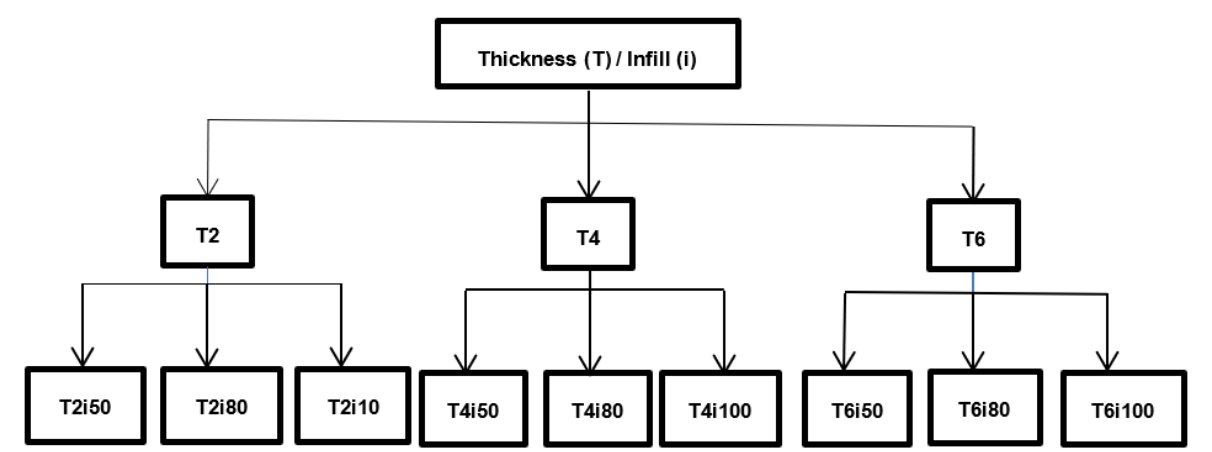
Figure 1. Description of the different plates and respective parameters.